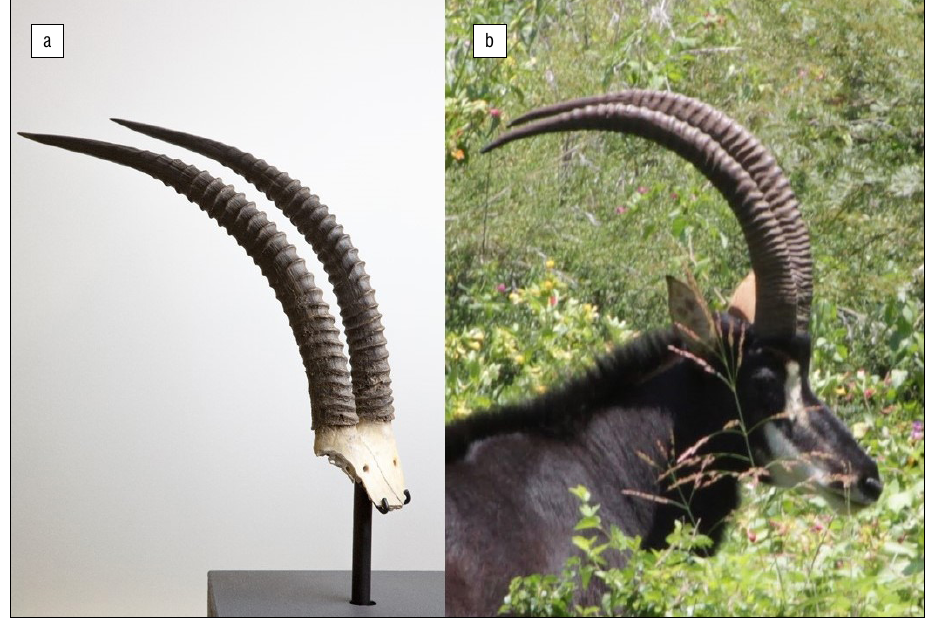
Figure 1: Images of (a) the Iziko Museum specimen (SAM ZM 40759) previously identified as a blue antelope and now shown to be a sable antelope (photo: Iziko Museums of South Africa/Nigel Pamplin) and (b) an adult sable antelope (photo: E. Le Roux), illustrating the annulated and back-swept horns characteristic of the hippotragine